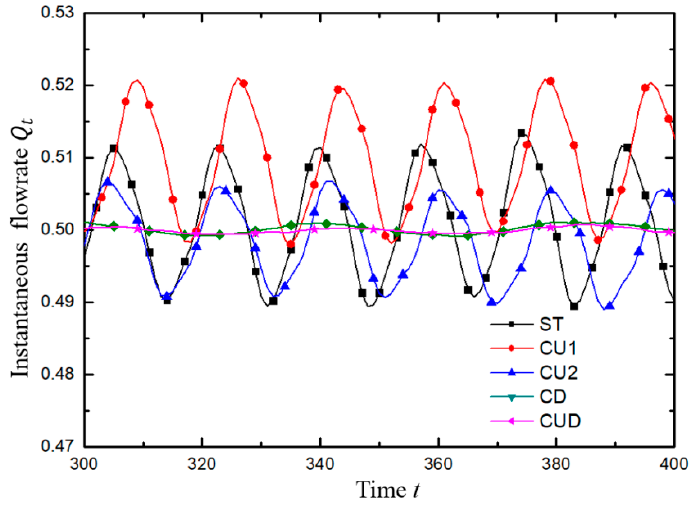
Figure 8. The variation of instantaneous flow rate 𝑄 𝑡 at the left outlet for different modified T-channel structures with dimensionless time. ( a ) CU1 structure; ( b ) CU2 structure; ( c ) CD structure; ( d ) CUD structure. Inset: For the cases of Newtonian fluid, beta0.1-Wi1, beta0.5-Wi1 and beta0.5-Wi5, the y -axis ranges are set to 0.48 to 0.53 to display more clearly, where the former three cases are nearly collapsed into a line with a value of 0.5.